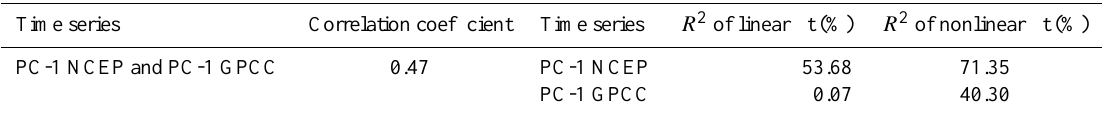
Table 2. Correlation coefficient between PC-1 of SPI for the two datasets NCEP/NCAR and GPCC (first two columns), and R 2 of the linear and nonlinear fittings of PC-1 (last three